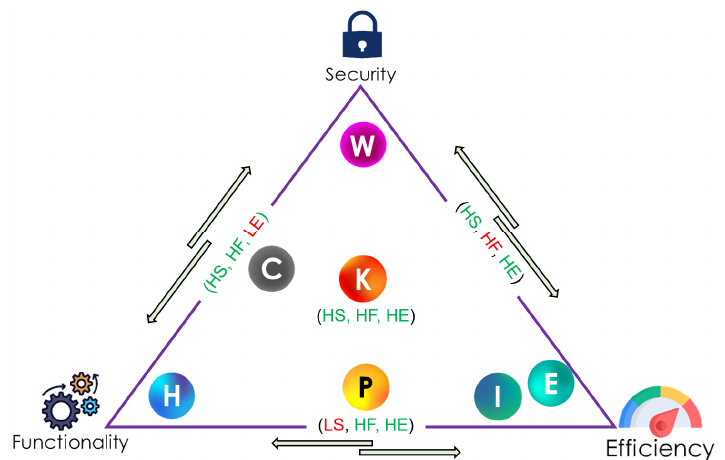
Figure 18. Overall comparison of the authentication protocols using triangular graph.